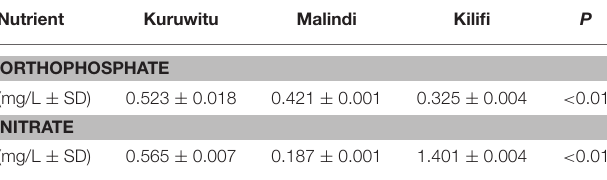
TABLE 1 | Nutrient mean concentrations for water samples collected from the coral reef sites. Nutrient Kuruwitu Malindi Kilifi P